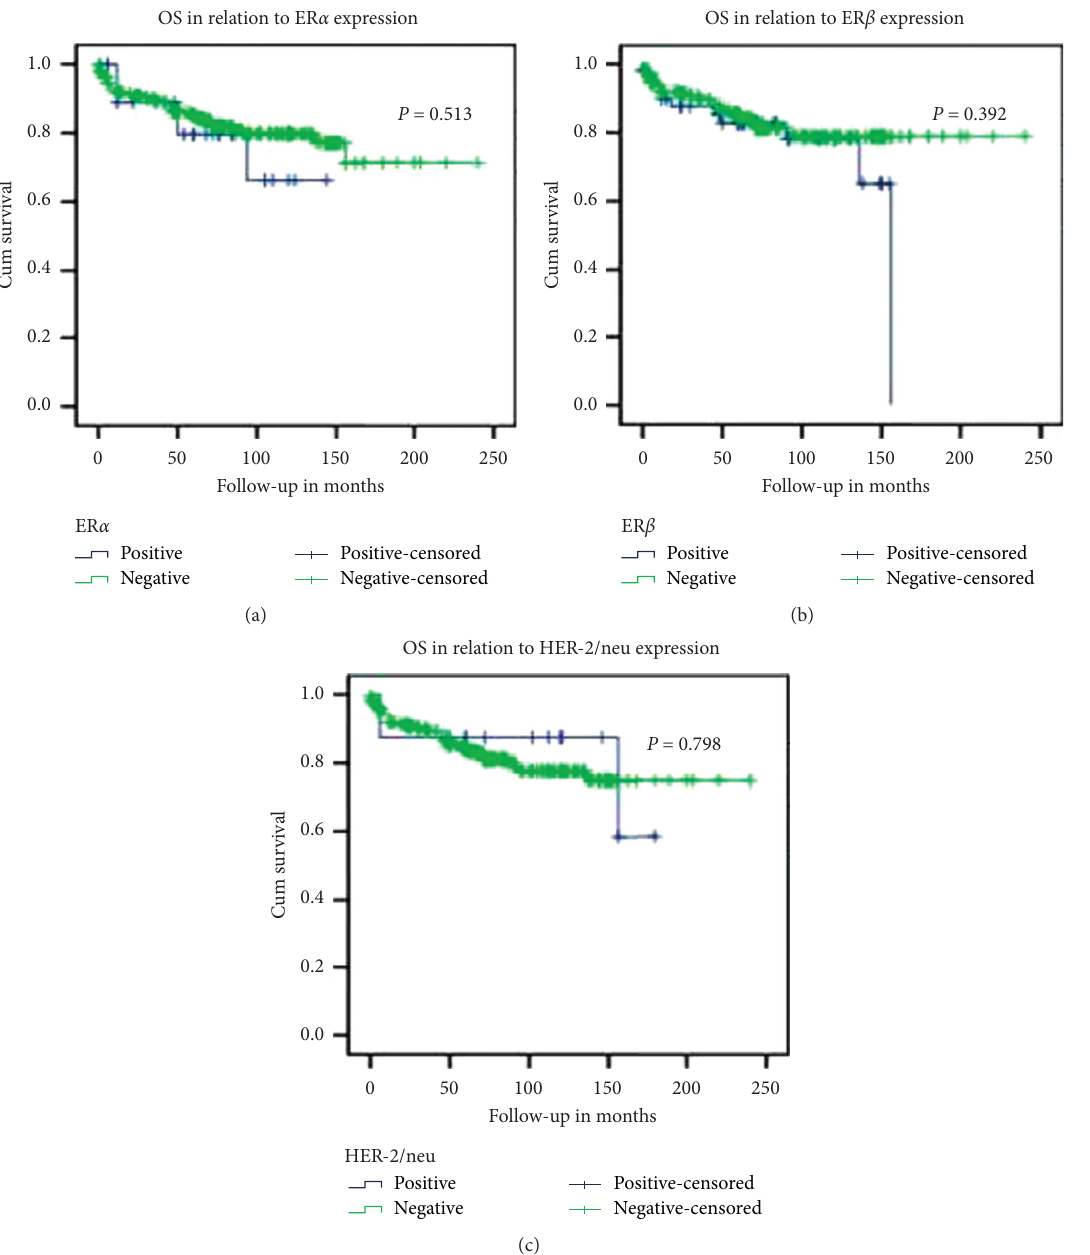
Figure 2: Overall survival in relation to (a) ER α , (b) ER β, and (c) HER-2